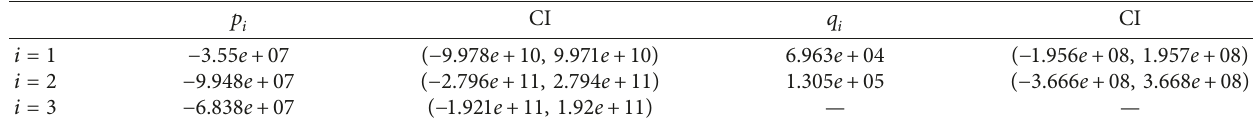
Table 7: R (− 1/2 ) vs. HoF.